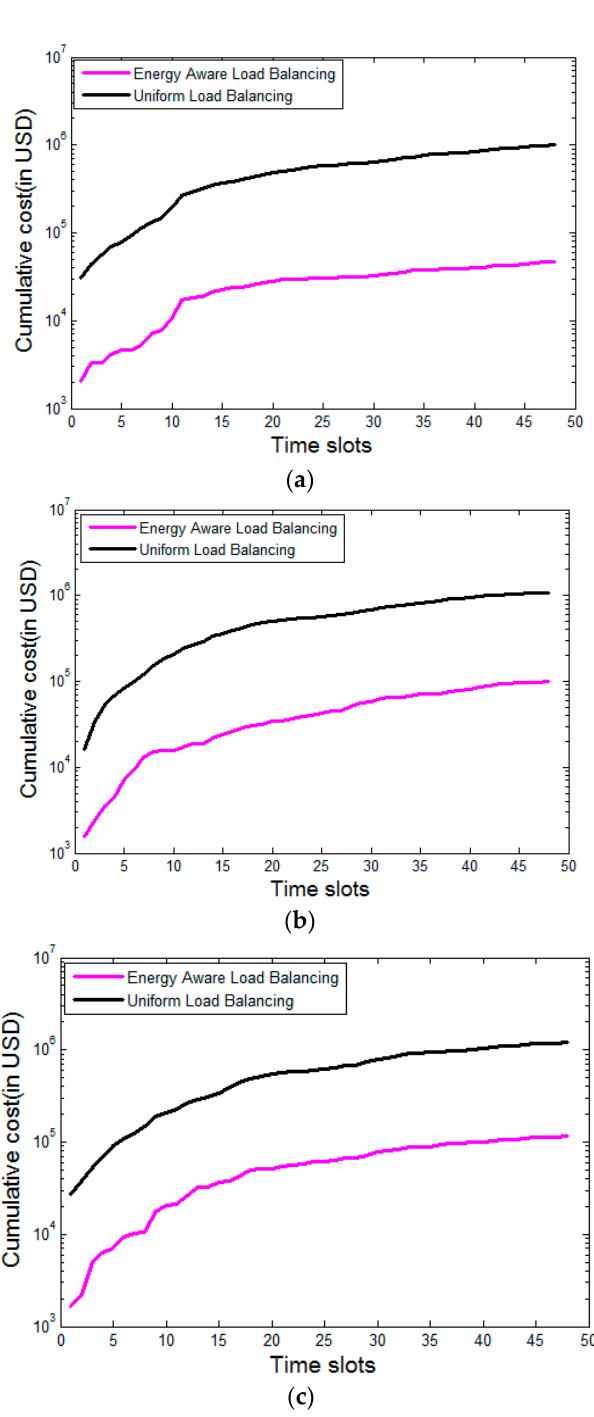
Figure 7. Comparison of cost incurred by the Infrastructure-as-a-Service (IaaS) providers with a uniform load distribution strategy ( a ) IaaS provider-1; ( b ) IaaS provider-2; and ( c ) IaaS provider-3.